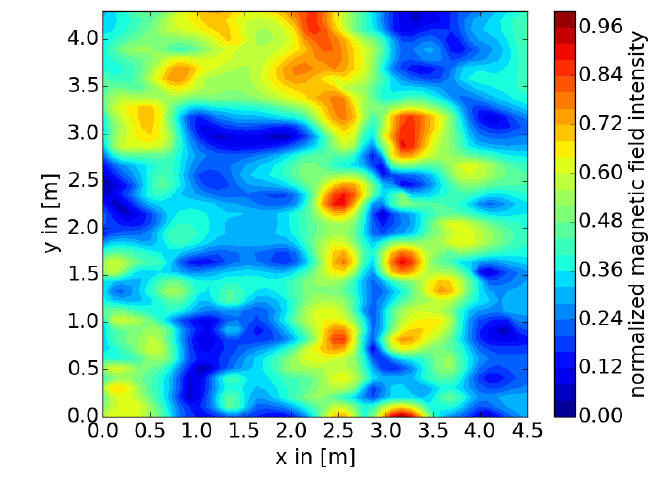
Figure 3. A part of the magnetic field on the ground of our laboratory. This plot shows the normalized magnetic field intensity in color coding. Red corresponds to a high magnetic field intensity, and blue corresponds to a low magnetic field